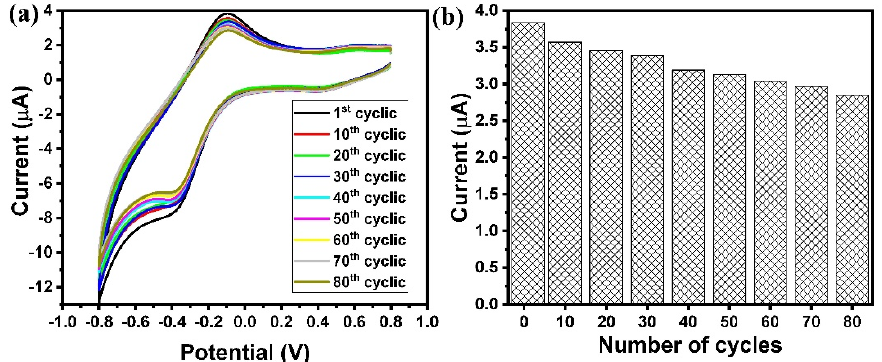
Figure 5. ( a ) Cyclic voltammograms of 10 − 9 mol L − 1 of MTX using P4d/Fe 3 O 4 /ITO electrode in PBS buffer pH = 7.4, scan rate = 50 mV/s, and ( b ) the calibration curve for the oxidation peak and the MTX concentrations.